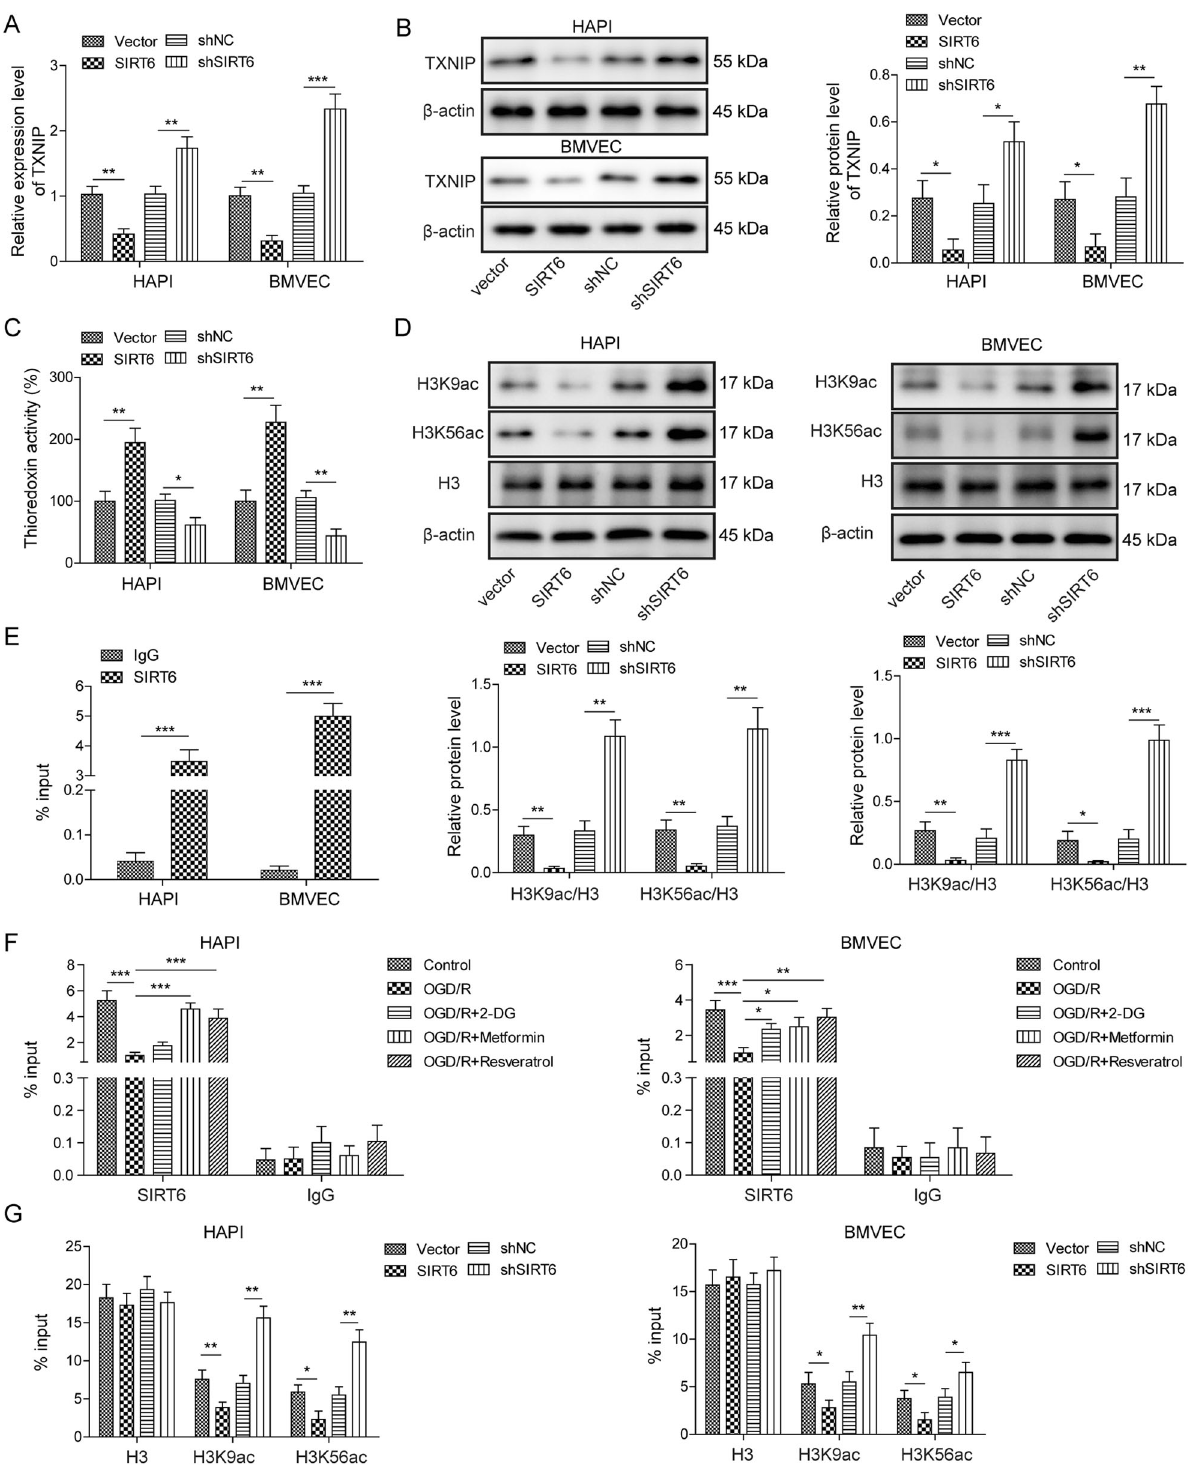
Fig. 5 SIRT6 suppresses TXNIP in HAPI cells and BMVECs via deacetylation of H3K9ac and H3K56ac. HAPI cells or BMVECs were infected with lentivirus for 48 h. A , B The mRNA and protein levels of TXNIP were determined by qRT-PCR and Western blotting, respectively. C Thioredoxin reductase activity was measured using commercial kit. D The protein levels of target proteins were determined by Western blotting. β -actin acted as a loading control for Western blotting. E , F The enrichment of SIRT6 at TXNIP promoter was determined by ChIP assay. Normal IgG served as a negative control. G The enrichments of total H3, H3K9ac, and H3K56ac at TXNIP promoter were determined by ChIP assay. * p < 0.05, ** p < 0.01, and *** p < 0.001.